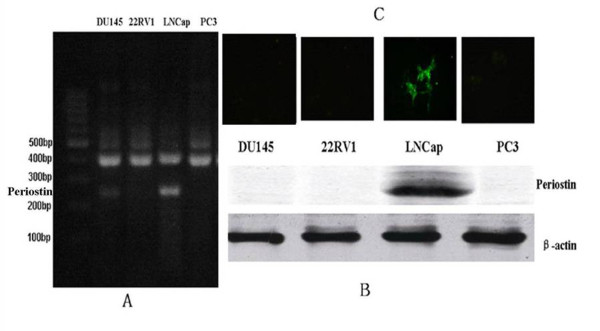
The expression of Periostin in different PCa cell lines. A: The results of RT-PCR analysis showed that the expression of Periostin mRNA was only detected in LNCap cells. B: The similar expression of Periostin protein in LNCap cells were confirmed by Western blot assay. C: The immunofluorescence staining indicated that green fluorescence only presented in LNCap cells and the other cell lines were negative.